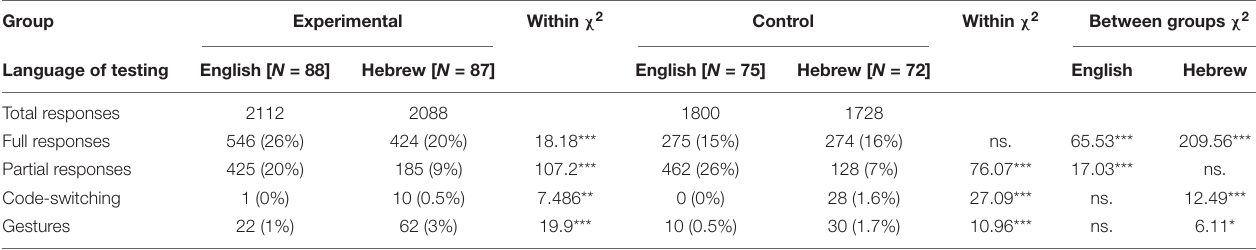
TABLE 3 | Descriptive statistics of the full corpus of responses.